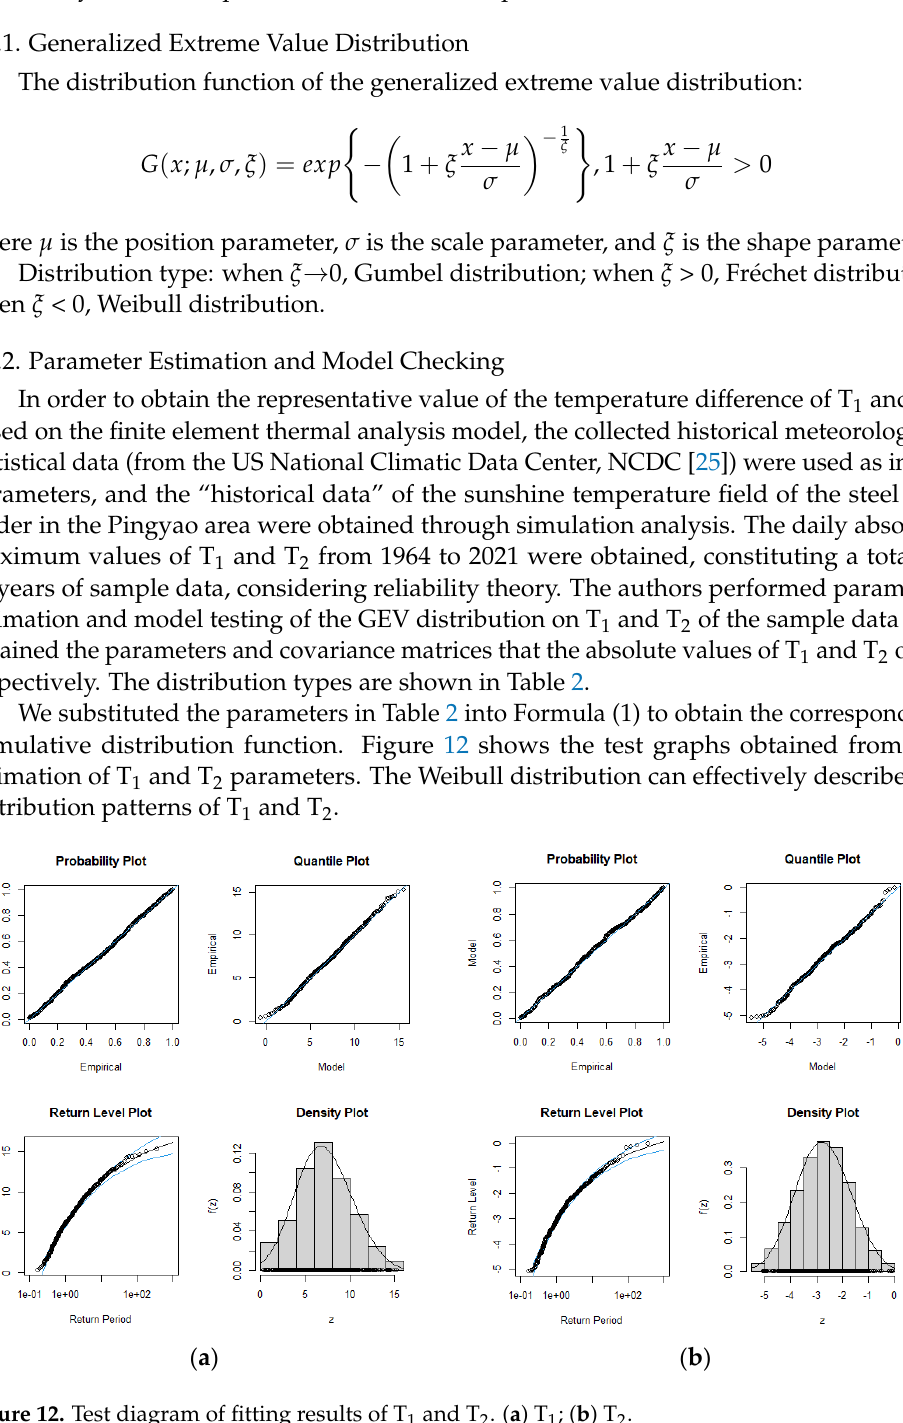
Figure 12. Test diagram of fitting results of T 1 and T 2 . ( a ) T 1 ; ( b ) T 2 .